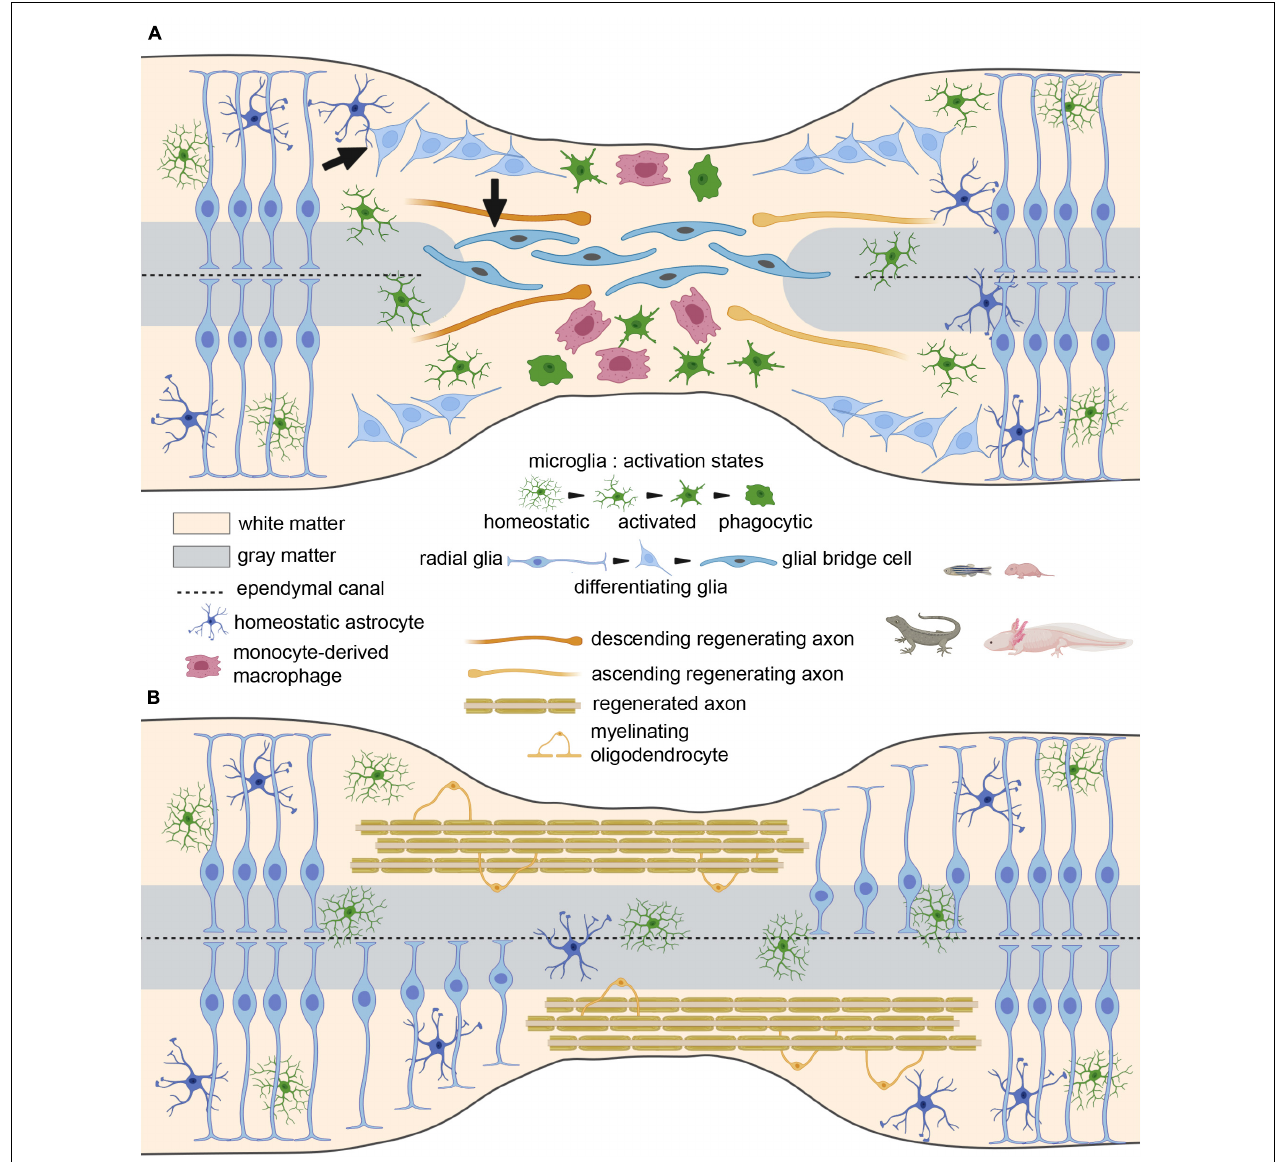
FIGURE 3 | The glial bridge after spinal cord injury in species with high regenerative capacities and perinatal mammals. (A) Tissue clearance, glial bridge, and axon sprouting at the acute/subacute stage. Arrows represent the involvement of radial glia in the glial bridge formation. (B) Remyelination and return to homeostasis at the chronic